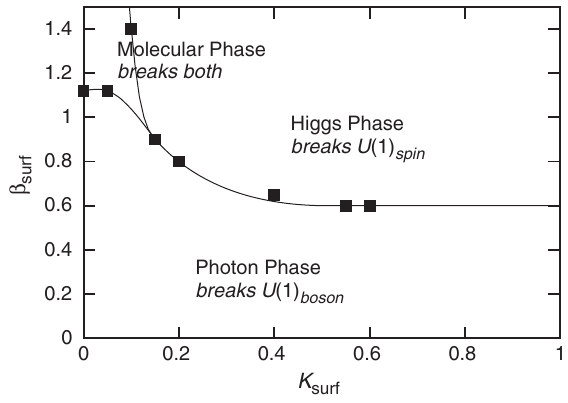
FIG. 11. Surface phase diagram on the boundary of the SPT phase in the model with a CP 1 version of the spins. The bulk ¼ 0 . 2 , K ¼ 0 . 2 , λ ¼ 8 , and the surface parameters are β bulk bulk parameters are varied. The phase diagram has the same structure as the one found in the NCCP 1 model in Ref. [30]. The phases are the same as those in Fig. 4, though in this figure we replace the SO ð 3 Þ symmetry with U ð 1 Þ , and the β axis is oriented surf spin horizontally in Fig. 4 and vertically in the present